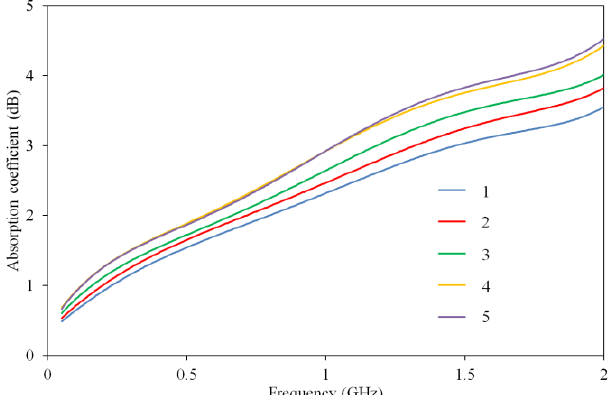
Figure 7. Frequency dependence of the EMR absorption coe ffi cient of the gelatin-PANI composite films: 1—2%-PANI-GEL; 2—36%-PANI-GEL; 3—46%-PANI-GEL; 4—53%-PANI-GEL; and